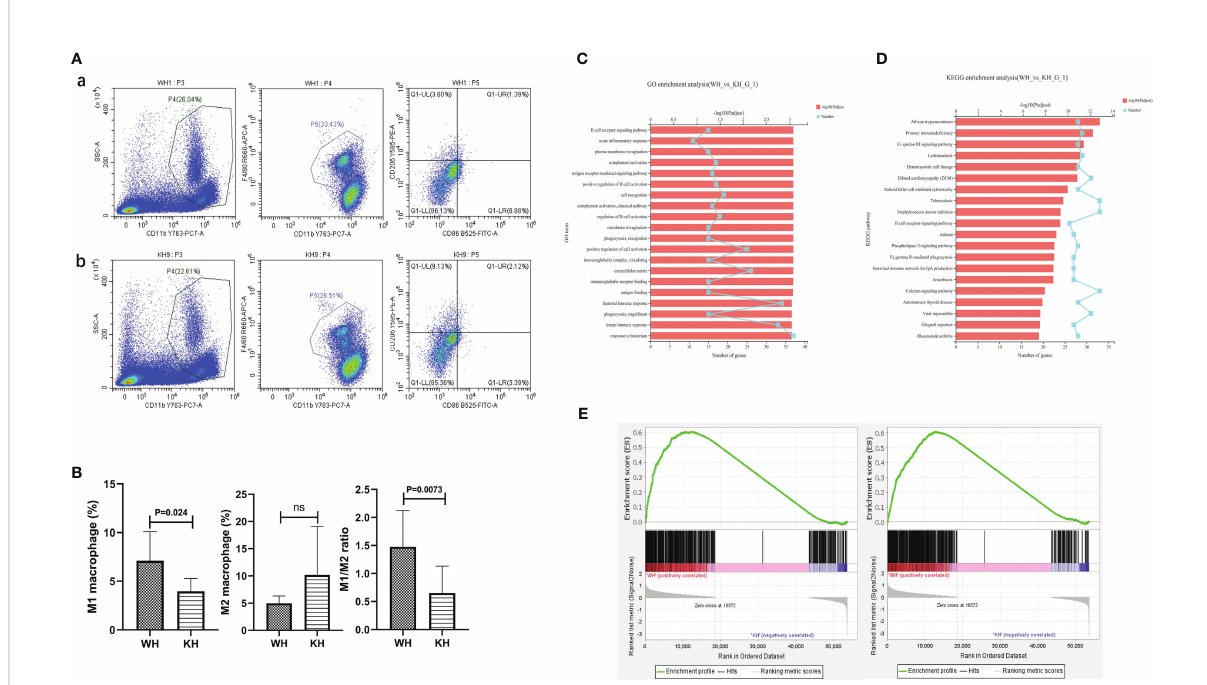
FIGURE 8 In vivo experiment of HK3 gene knockout mice. (A) Flow cytometry of macrophage proportions in spleen tissue. a: WH group; b:KH group; (B) Statistics of macrophage proportions; (C) GO analysis; (D) KEGG analysis; (E) GSEA of macrophage polarization in transcriptome of thyroid tissue from WH group (From left to right: M1 and